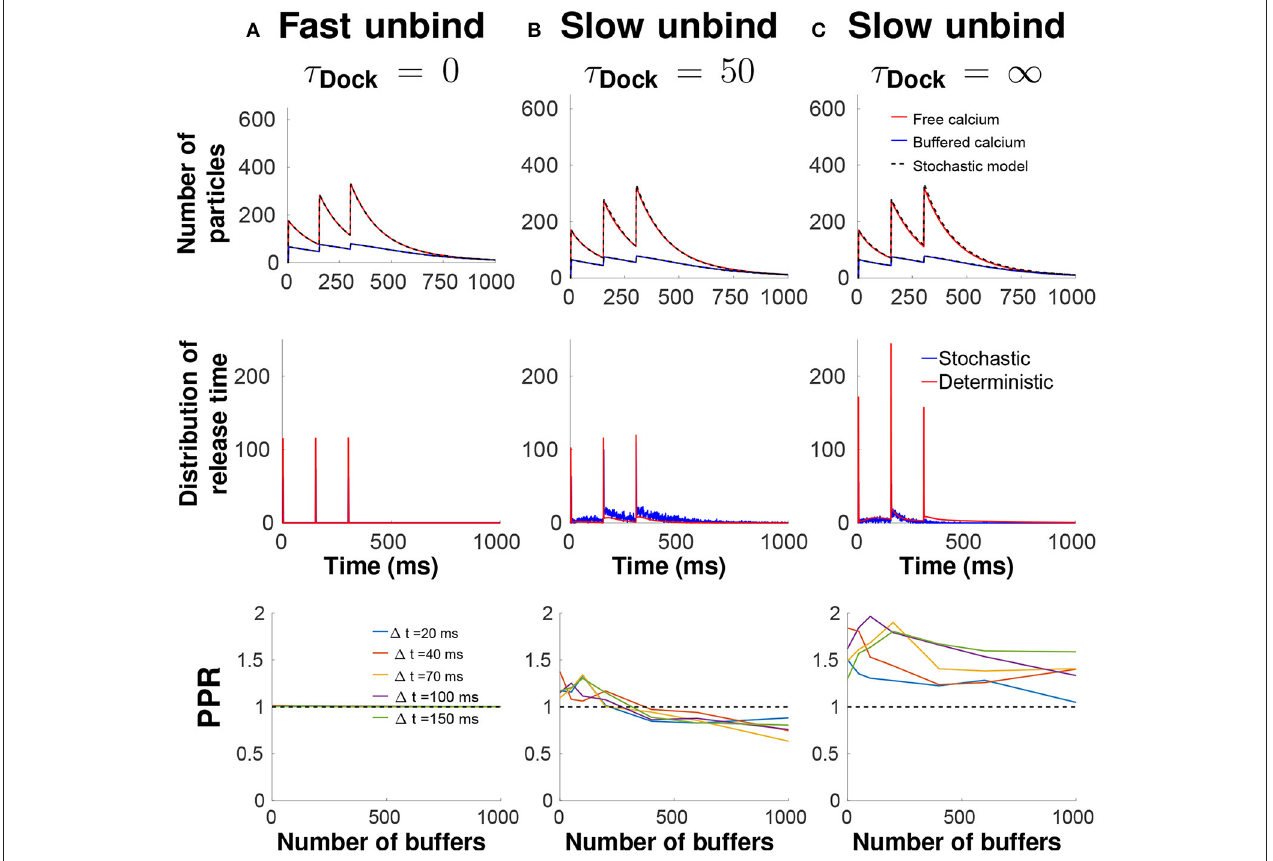
FIGURE 4 | Calcium dynamic and vesicular release in the pre-synaptic terminal following three pulses. Comparison between slow unbinding from the Snare ( k U = 0.005 ms − 1 ) with the vesicle docking time τ D 0ms (A) , fast unbinding ( k U 2 ms − 1 ) with τ D 50 ms (B) , and fast unbinding with τ D (C) for 100 buffer = = = = ∞ molecules and 150 ms between two spikes. Up: Time course of free calcium (red) and buffered calcium (blue). Middle: Probability density function of the release times. Down: Paired Pulse Ratios (PPR), computed as the ratio of the number of fused vesicles during the first and the second